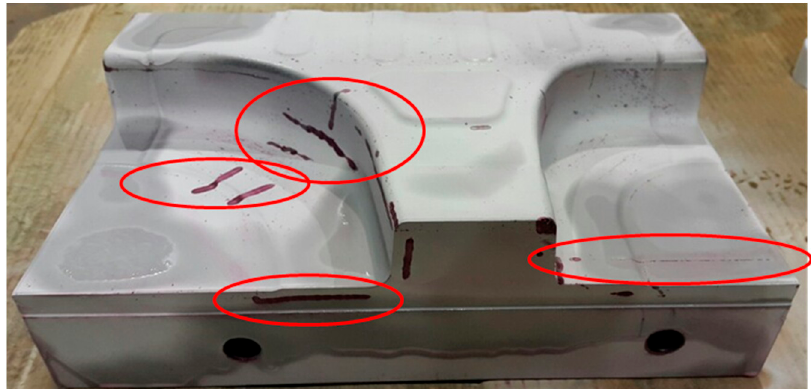
Figure 15. Cracks observed in the liquid penetration test after additive manufacturing and surface Figure 15. machining.